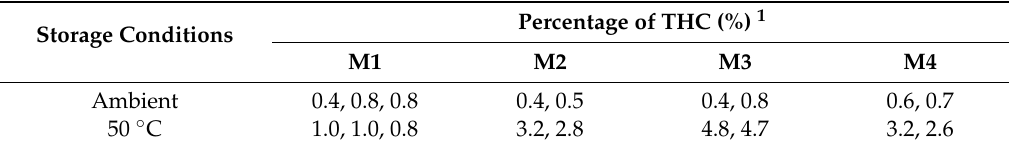
Table 2. Percentages of ∆ 9 -tetrahydrocannabinol (THC) in cannabis plants stored at ambient conditions and at 50 ◦